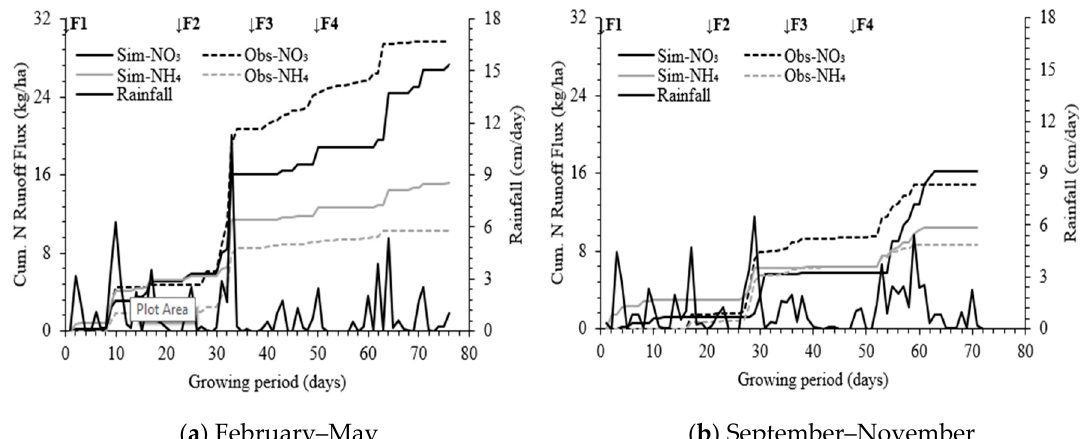
Figure 9. Comparison of simulated (Sim.) and observed (Obs.) cumulative N runoff fluxes during the ( a ) first season and ( b ) second season.